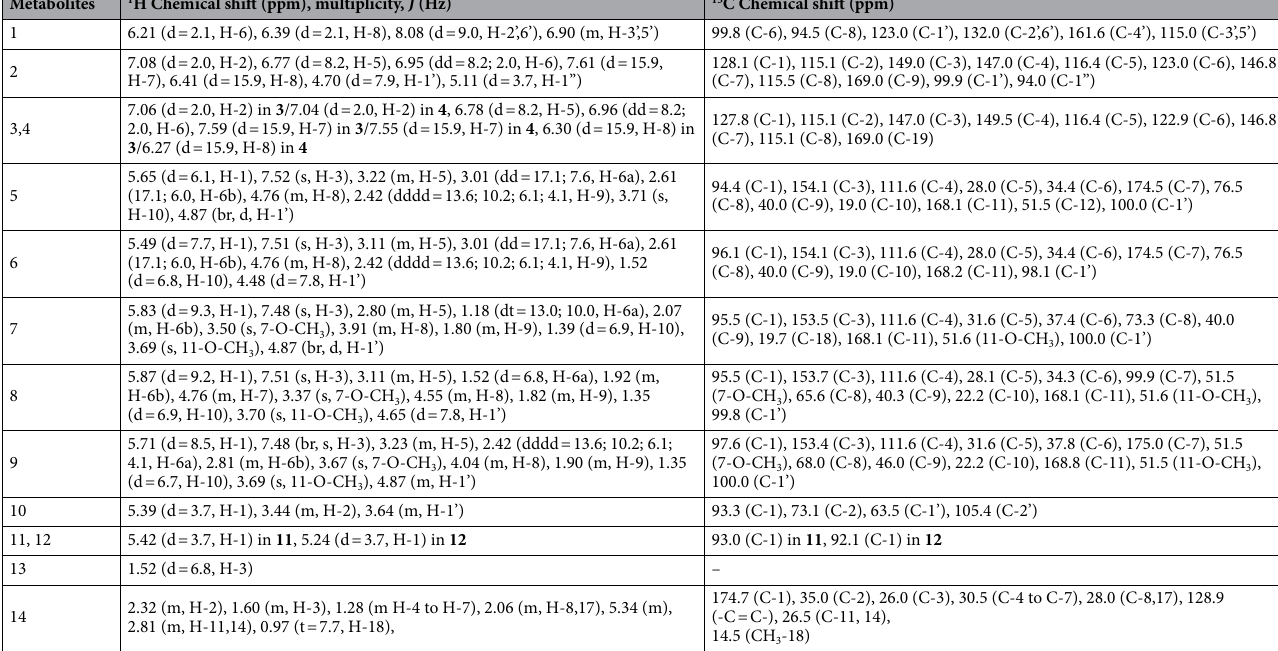
and H-8 (δ H 6.41, d, J = 16.0 Hz), while the attached glucose units were illustrated by the anomeric protons of β -H-1 ′ (δ H 4.70, d, J = 7.9 Hz) and α -H-1 ″ (δ H 5.11, d, J = 3.7 Hz). The carbon assignments of 2 were completed in multiplicity edited 2D ( 1 H- 13 C) HSQC NMR (Supplementary Fig. S8) that showed carbons at δ C 115.1 (C-2), 116.4 (C-5), 123.0 (C-6), 146.8 (C-7), 115.4 (C-8), 99.9 (C-1 ′ ) and 94.0 (C-1 ″ ). Analysis of 2D ( 1 H- 13 C) HMBC NMR (Supplementary Fig. S9, and Fig. 3) confirmed 2 by means of basic correlations from H-2 (δ H 7.08, d, J = 2.0 Hz) to C-3 (δ C 149.0), C-4 (δ C 147.0) and C-6 (δ C 123.0), from H-5 (δ H 6.77, d, J = 8.2 Hz) to C-1 (δ C 128.1), C-3 (δ C 149.0), C-4 (δ C 147.0) and C-6 (δ C 123.0), from H-6 (δ H 6.95, dd, J = 8.2; 2.0 Hz) to C-2 (δ C 115.1), C-3 (δ C 149.0) and C-4 (δ C 147.0), from H-7 (δ H 7.61, d, J = 16.0 Hz) to C-1 (δ C 123.0), C-2 (δ C 115.1) and C-9 (δ C 169.0), from H-8 (δ H 6.41, d, J = 16.0 Hz) to C-1 (δ C 128.1), C-9 (δ C 169.0) and C-1 ′ (δ C 99.9), from H-1 ′ (δ H 4.70, d, J = 7.9 Hz) to C-1 ″ (94.0), 77.7 and 75.1, from H-1 ″ (δ H 5.11, d, J = 3.7 Hz) to C-1 ′ (99.9) representing the attachment of two glucose units. Without additional correlations, the chemical structure of 2 was completed as a caffeoyl moiety attached to β -D-glucose and α -D-rhamnose (Table 2), following literature 17 . In line with literature 27 , sample analysis by LC–MS/MS in ESI − mode revealed the presence of two caffeoylquinic acids—e.g., 3- O -caffeoylquinic acid ( 3 ) and 5- O -caffeoylquinic acid ( 4 ). These derivatives were differentiated by giving single molecular ion peak at m/z 353. However, using a similar collision energy (22 V), MS 2 fragments for compound 3 were m/z 135, 179 and 191, when compared with 4 that exhibited a majority of m/z 191 (Supplementary Figs. S4 to S5, and Table 1) that was similar to the previously published results 27 . In 1 H HR-MAS NMR (Table 2), metabolites 3 and 4 were observed identical to 2 , but were different due to the peaks from the aromatic ring protons and the vinylic protons. In this regard, 1 H HR-MAS NMR presented the aromatic ring protons of H-2 (δ H 7.06, d, J = 2.0 Hz), H-5 (δ H 6.78, d, J = 8.2 Hz) and H-6 (δ H 6.96, dd, J = 8.2; 2.0 Hz), and the vinylic protons of H-7 (δ H 7.59, d, J = 16.0 Hz) and H-8 (δ H 6.30, d, J = 16.0 Hz) in 3 , and except for the protons of H-2 (δ H 7.04, d, J = 2.0 Hz), H-7 (δ H 7.55, d, J = 16.0 Hz) and H-8 (δ H 6.27, d, J = 16.0 Hz), the remaining chemical shifts from 4 were compatible with those observed for metabolite 3 . Carbon assignments in 3, 4 were accomplished by 2D ( 1 H- 13 C) HSQC NMR (Supplementary Fig. S8), showing carbons at δ C 115.1 (C-2), 116.4 (C-5), 123.0 (C-6), 146.8 (C-7), 115.1 (C-8) and 169.0 (C-9). In 2D ( 1 H- 13 C) HMBC NMR (Supplementary Fig. S9, and Fig. 3), 3 , 4 given key correlations from H-2 (δ H 7.06, d, J = 2.0 Hz) to C-3 (δ C 147.0), C-4 (δ C 149.5) and C-6 (δ C 123.0), from H-5 (δ H 6.78, d, J = 8.2 Hz) to C-1 (δ C 127.8), C-3 (δ C 147.0), C-4 (δ C 149.5) and C-6